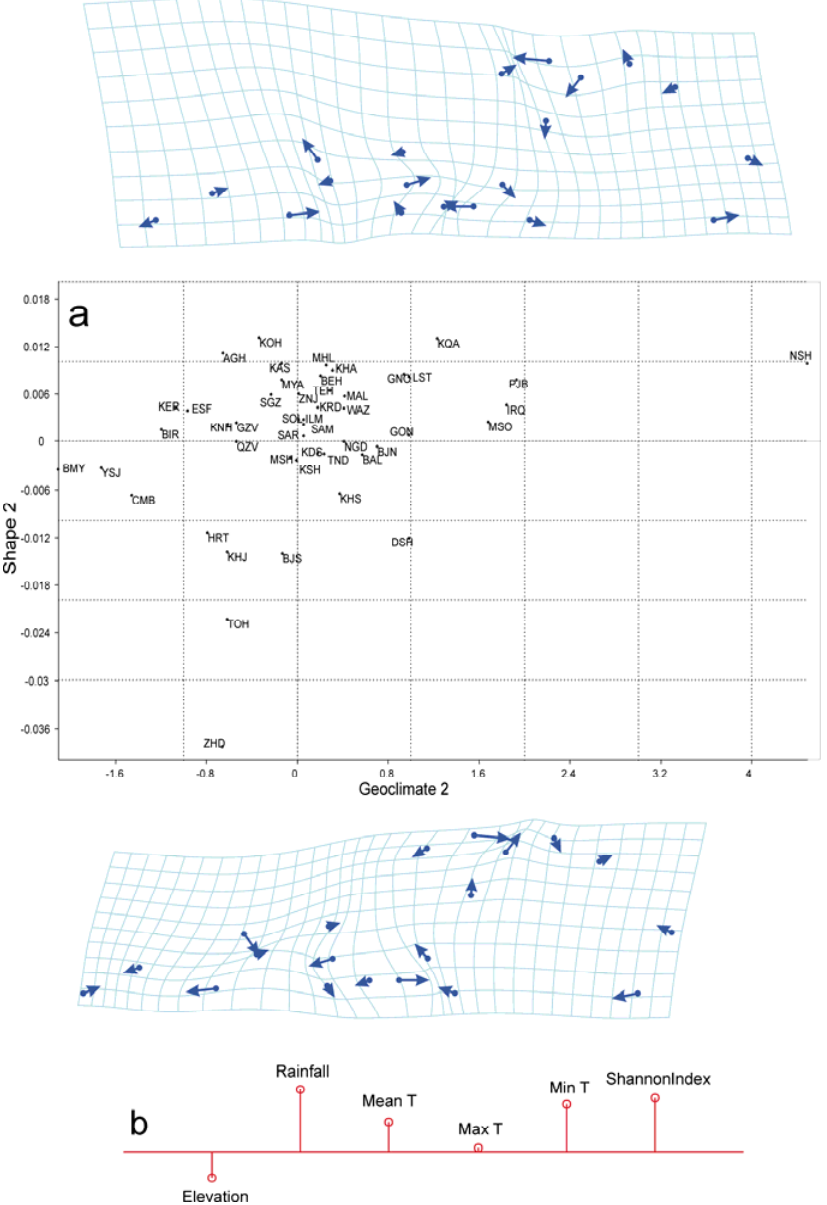
F IGURE 4. graphical representation of 2B-PLS results, based on the second paired vectors of shape and geoclimatical data (a) scatter plot showing the projections of the M. persicus populations onto the second shape and geoclimatical vectors; Grids: TPS deformations to the negative (bellow) and positive directions (above) with respect to the consensus configuration. (b) variable profile plot for the geoclimatical variables (variable profile plot shows the structure of the environmental gradient associated with the Geoclimate singular vector 2. The sign and magnitude of correlation coefficients are depicted by the position and size of bars,